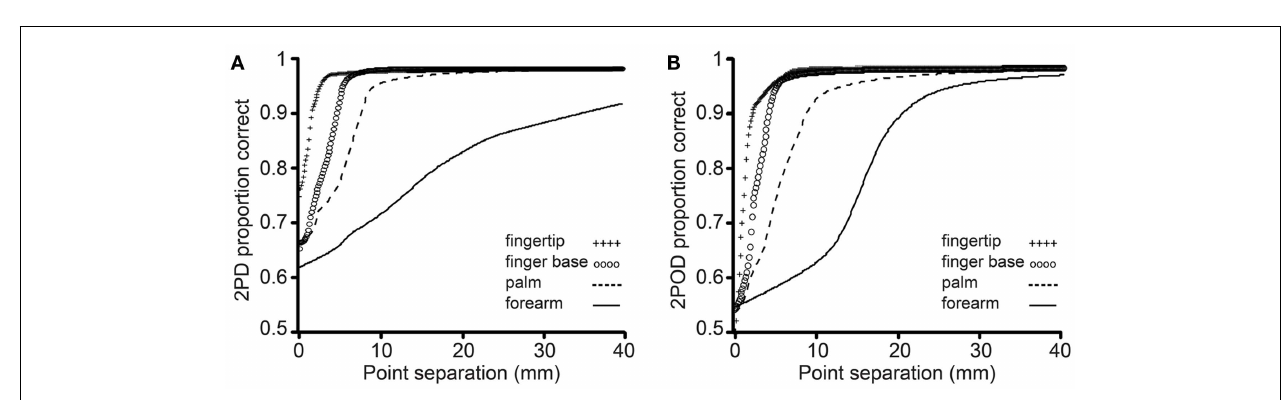
FIGURE 3 | Bayesian adaptive testing procedure . Plots illustrate the trial-by-trial performance (upper) and gamma parameter posterior density (lower) for experiments done on the finger base of one participant. (A) 2PD task. (B) 2POD task. Crosses represent incorrect responses; circles, correct responses. Note that, at zero mm tip separation, this participant answered